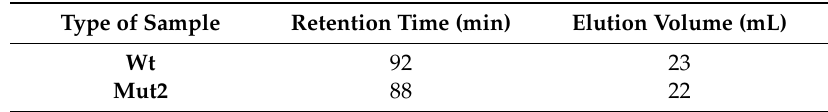
Table 5. Retention time and elution volume of Wt and Mut2 8S α globulin after HIC using Biorad butyl toyopearl.